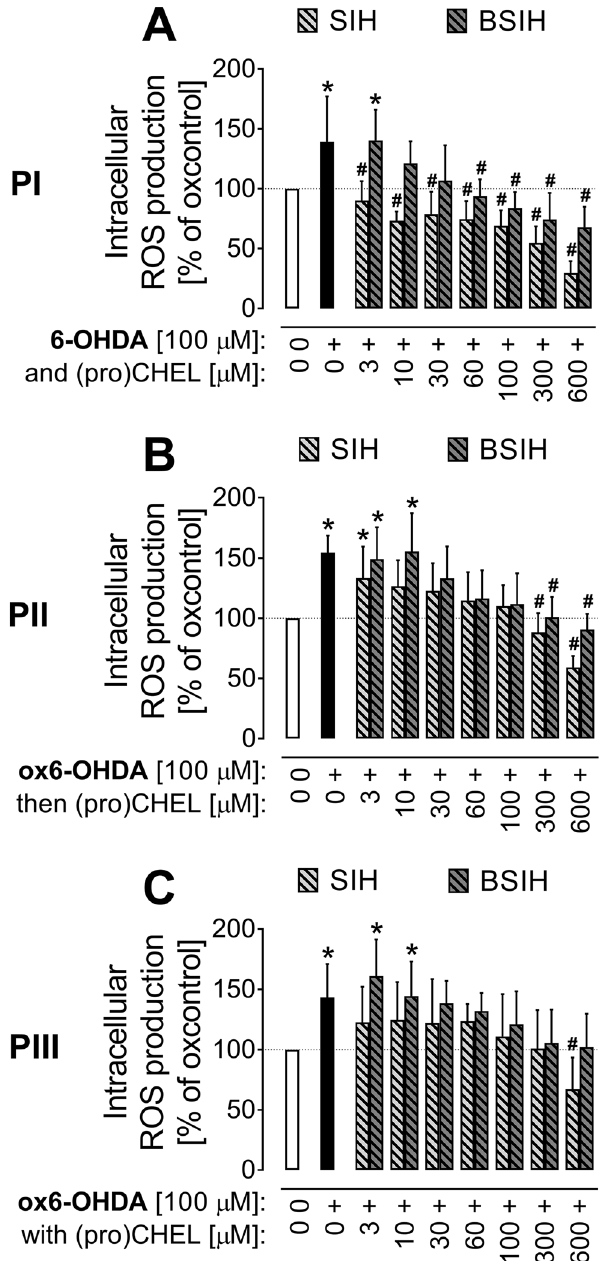
Figure 7. Comparison of effects of Fe chelator SIH and prochelator BSIH on cellular oxidative stress induced by 6-hydroxydopamine (6-OHDA) and its 24 h-preoxidized form (ox6-OHDA). Intracellular reactive oxygen species (ROS) formation was determined by H 2 DCF-DA assay following the 30 min treatment of differentiated PC12 cells with a combination of 6-OHDA (100 µM) and Fe (pro)chelator (0–600 µM). ROS production (intracellular fluorescence) was expressed as a percentage of the untreated control group. Cells were incubated for 24 h with various concentrations of SIH or BSIH added to: freshly-prepared 6-OHDA ( A ; protocol PI ); to medium with 24 h-preoxidized 6-OHDA ( B ; protocol PII ); or to medium with 6-OHDA at the beginning of 24 h preincubation ( C ; protocol PIII ). Data are presented as means ± SD ; n = 4; Statistical significance (ANOVA, p ≤ 0.05): * vs. control group, # vs. corresponding catecholamine